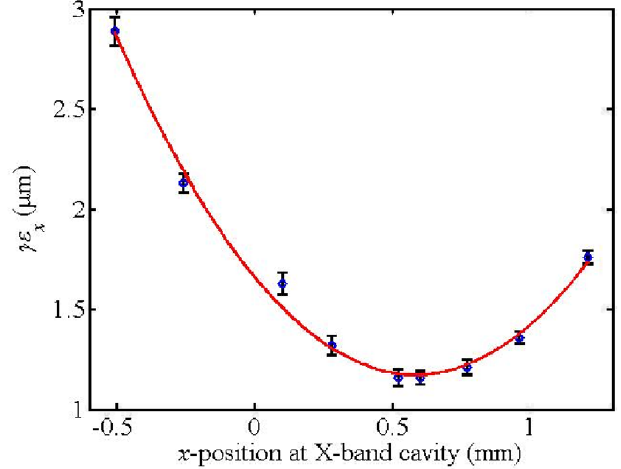
FIG. 40. (Color) Horizontal emittance at 250 MeV after BC1 as the beam x -position is varied in the X-band rf structure. The charge is 0.7 nC, and the BC1 chicane and X-band rf are both switched off (the L1S rf is at crest phase).